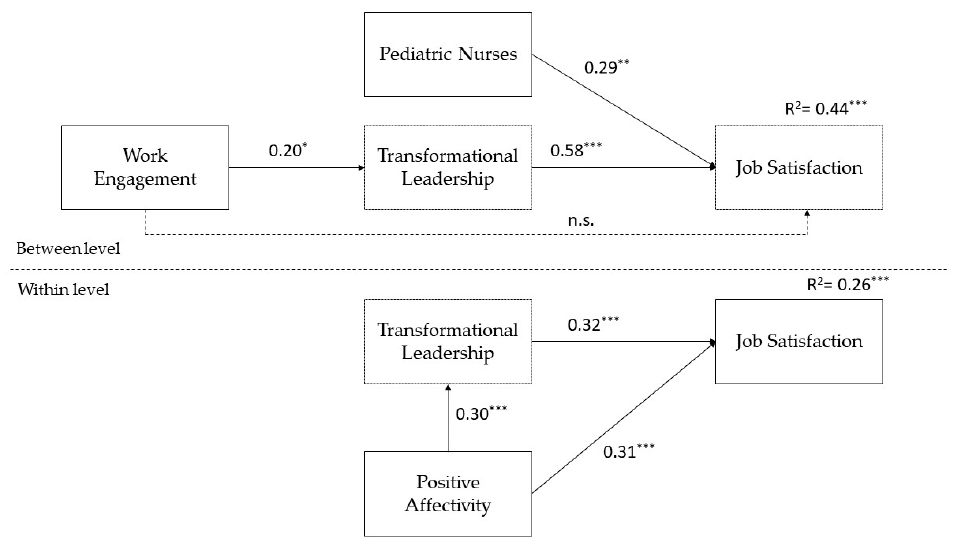
Figure 1. Results of Model 2 with standardized estimates. Note: * p < 0.05; ** p < 0.01; *** p < 0.001. Discontinuous lines indicate non-significant relationships.